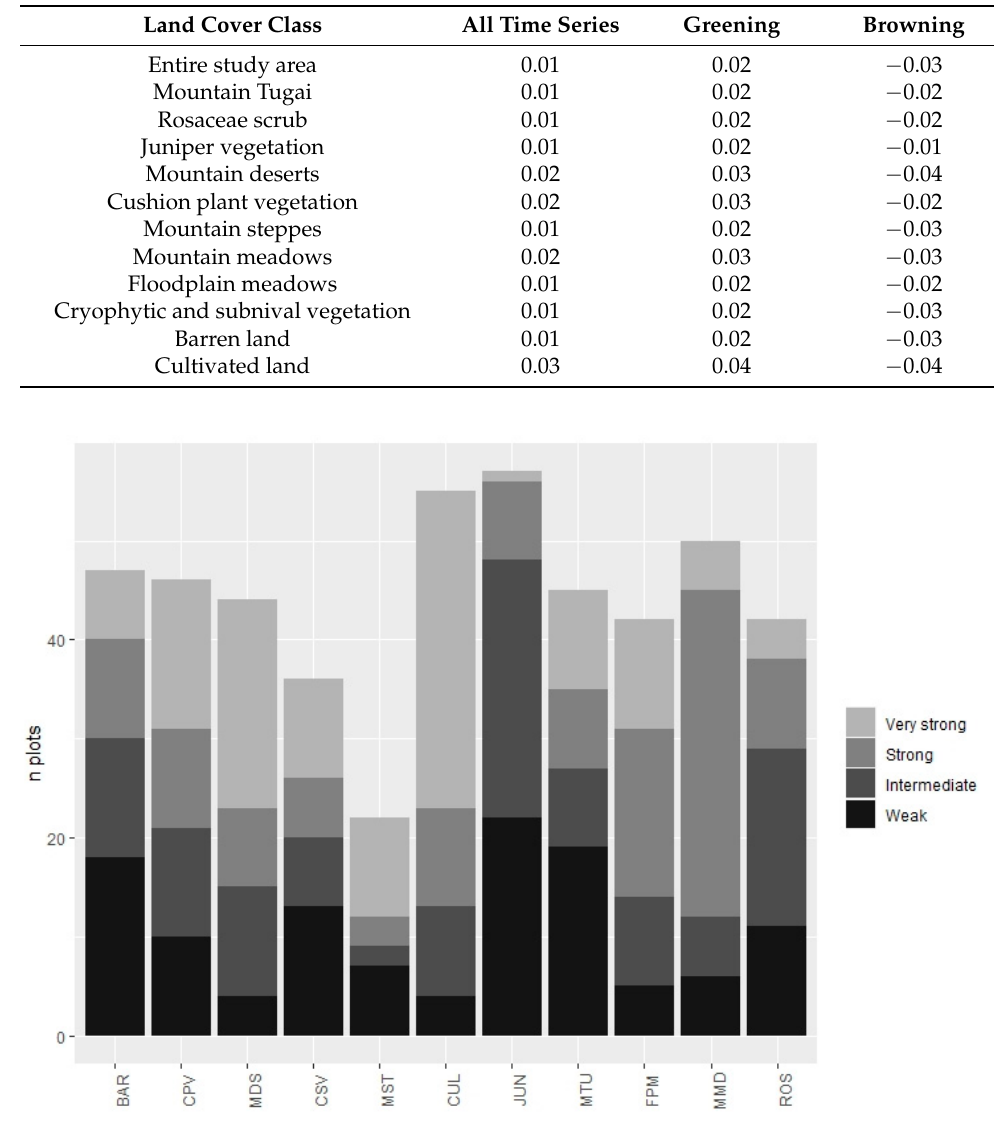
Figure 5. Strength of significant positive change for each land cover class. BAR: barren land; CPV: cushion plant vegetation; MDS: mountain deserts; CSV: cryophytic and subnival vegetation; MST: mountain steppes; CUL: cultivated land; JUN: juniper vegetation; MTU: mountain Tugai; FPM: floodplain meadows; MMD: mountain meadows; ROS: Rosaceae scrubs. Analogous to the plots with a significant positive change, we calculated the quartiles of the modulus of the change values in the test plots with a significant negative change ( n = 26). Again, we compared the land cover classes based on their share of change values in the four categories (Figure 6). There are no plots with a significant negative change among Rosaceae scrubs, cushion plant vegetation, and cryophytic and subnival vegetation. The highest number of negative changes was found in mountain Tugai, though most plots fall into the category of weak negative change. Very strong and strong negative changes predominantly occur in mountain meadows, followed by cultivated